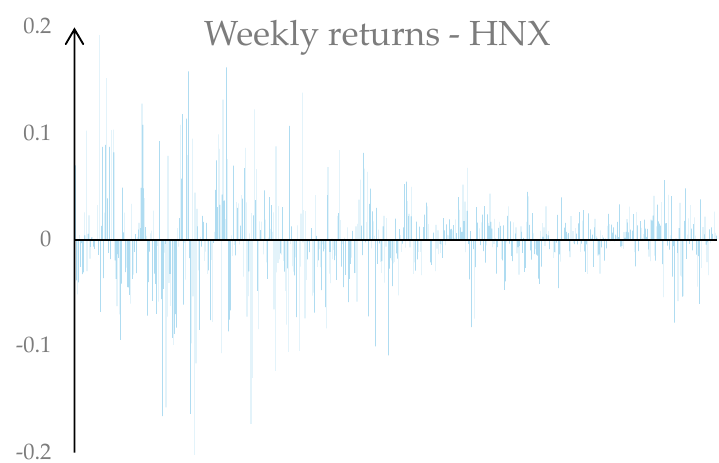
Figure 2. The weekly returns of Hanoi Stock Exchange (HNX) in the period from 2006 to 2019.